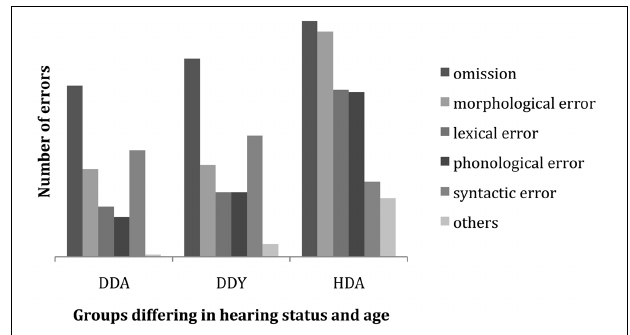
FIGURE 5 | Incidence and proportion of error type by fluency